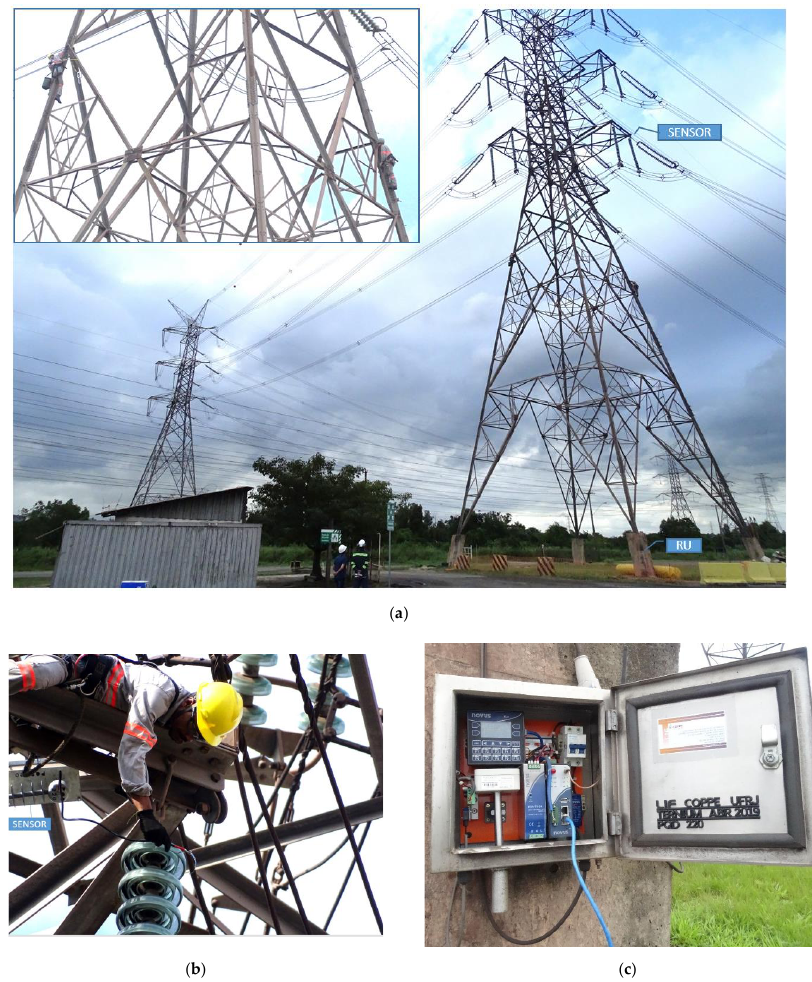
Figure 6. ( a ) Live-line personnel climbing Tower 19 for the installation of the sensor; ( b ) The technician is connecting the sensor between the two last sheds of a 25-unit insulator string; ( c ) The remote unit (RU), fixed at the foot of the tower.